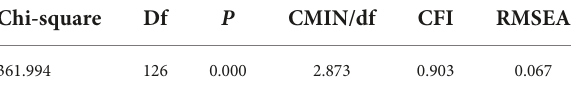
TABLE 3 CFA results of model